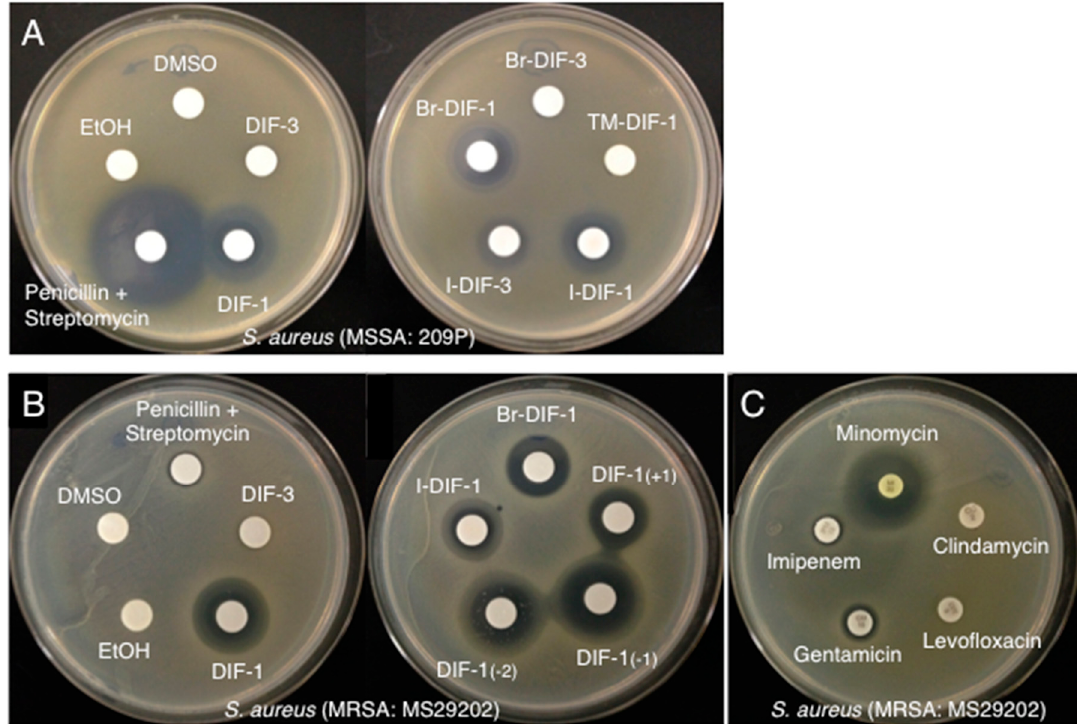
Figure 2. ( A ) E ff ects of DIF derivatives on the growth of methicillin-susceptible Staphylococcus aureus (MSSA) on agar. Paper discs were placed on Mueller–Hinton broth (MHB) agar plates that contained MSSA (209P); paper discs were impregnated with 2 µ L of either ethanol (EtOH; vehicle), DMSO (vehicle), a 10 mM solution of the indicated DIF or DIF derivative, or a mixture of penicillin (5000 units / mL) and streptomycin (5 mg / mL). After incubation for 20 h at 37 ◦ C, bacterial growth-inhibition zones around the discs were noted. ( B , C ) E ff ects of DIF derivatives on the growth of methicillin-resistant S. aureus (MRSA) on agar. Paper discs were placed on MHB agar plates that contained MRSA (MS29202); these discs were impregnated with 2 µ L of either EtOH (vehicle), DMSO (vehicle), a 10 mM solution of the indicated DIF or DIF derivative, or a mixture of penicillin and streptomycin ( B ). In addition, paper discs containing the indicated antibiotics were placed on MRSA agar plates ( C ). After incubation for 20 h at 37 ◦ C, bacterial growth-inhibition zones around the discs were